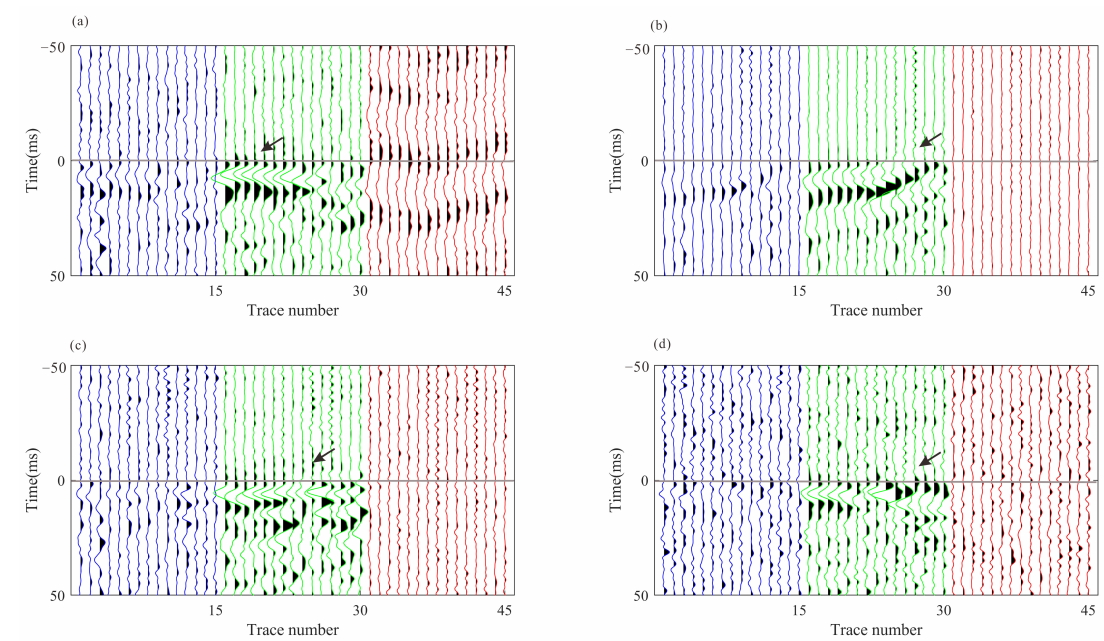
Figure 12. S-waves of four microseismic events recorded by 15 receivers after moveout correction. The horizontal gray line represents S-wave arrivals. ( a – d ) are S-wave recordings from the four events in Figure 10. Blue, green, and red lines represent rotated x-, y-, z- components, respectively. The arrows indicate the local inconsistencies between waveforms.